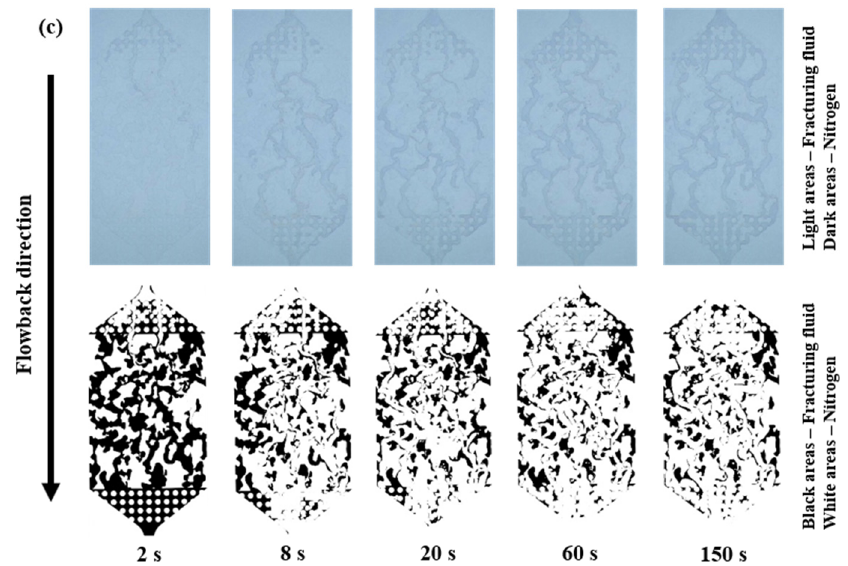
Figure 8. The fracturing fluid (0.8 wt%) flowback process images and binary images ( a ) 0.1 MPa gas drive, ( b ) 0.2 MPa gas drive, ( c ) 0.3 MPa gas drive.